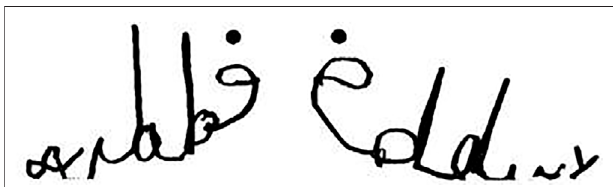
FIGURE 3 | Eddy ’ s writing of his name, at age 6 years and 3 months, with his usual right hand in two different conditions (data from Fischer and Tazouti, 2012); note the reversal of d in b in the left part of the fi